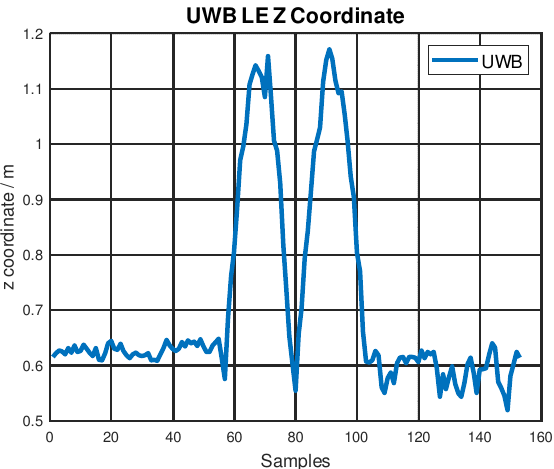
Figure 6. UWB LE raw data measurements on the z -axis during dynamic